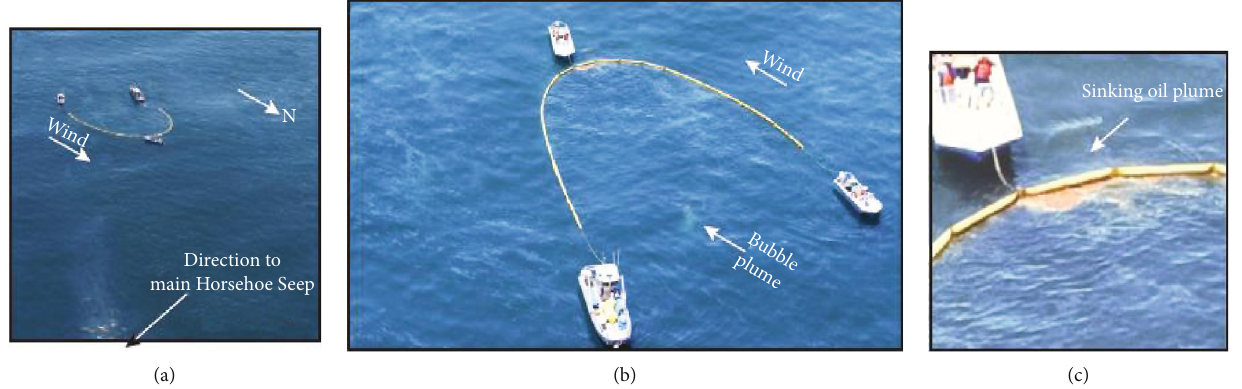
Figure 25: (a, b) Photos of a seep oil assessment experiment for a single, isolated seep plume near Horseshoe Seep. (c) Zoomed image of collected surface oil. From Lorenson et al. [125]. Photo courtesy: Chris McCullough, California Dept. of